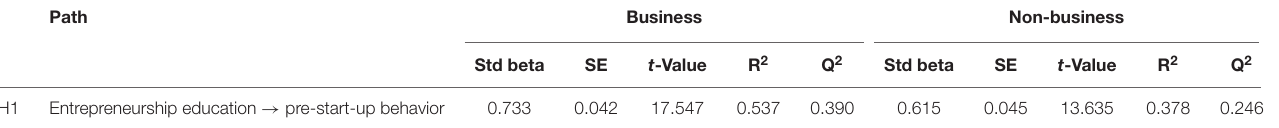
TABLE 10 | Structural model assessment (Split